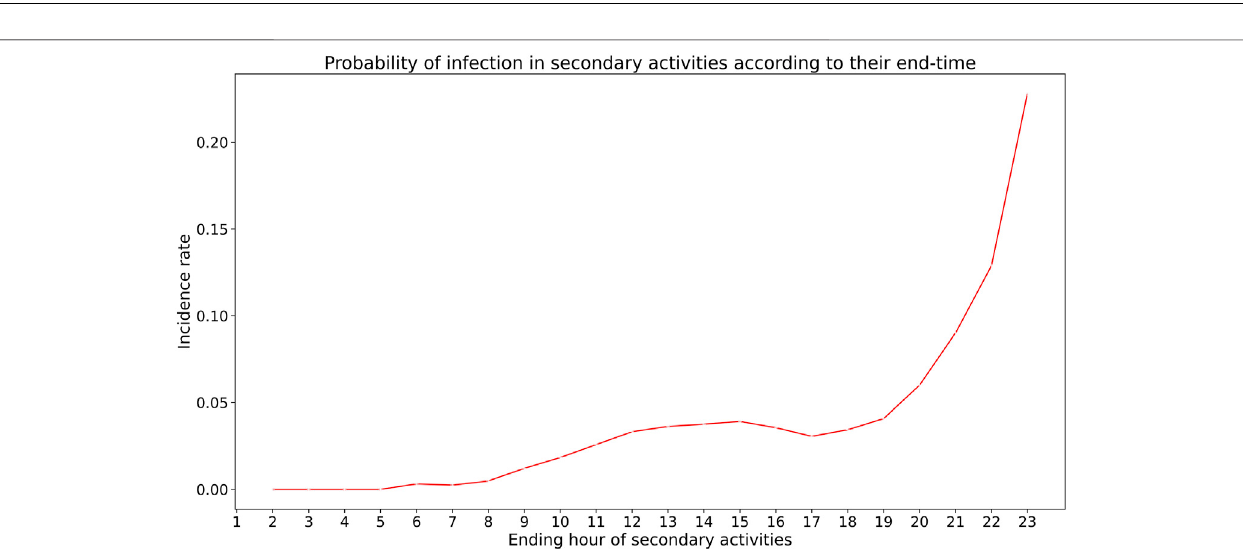
FIGURE 9 | Empirical probability of infection in secondary activities according to their end-time.